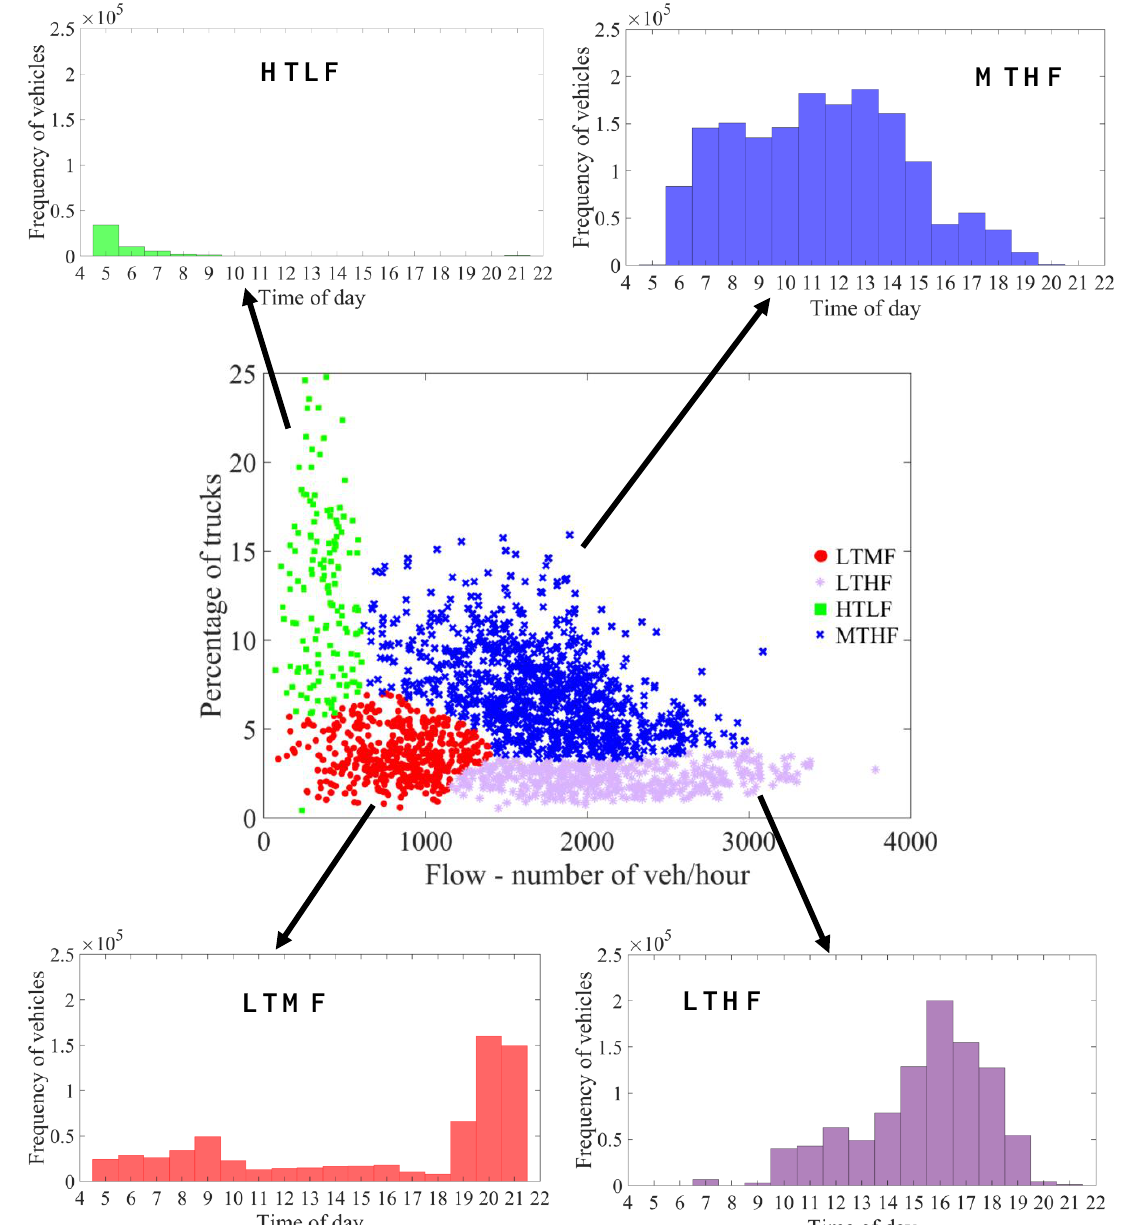
Figure 6. Data illustrated as four different clusters.